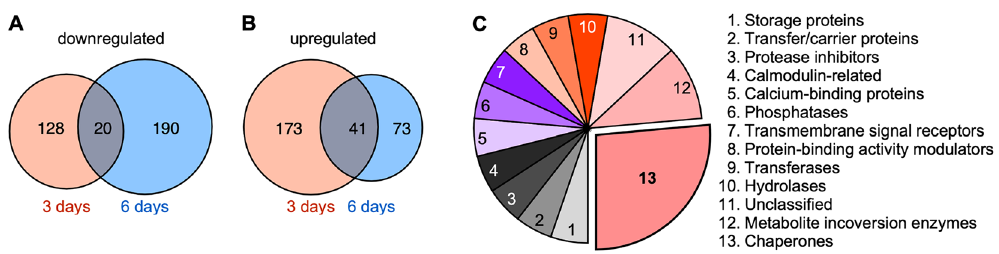
Figure 3. Comparison of the DAPs after a 3-d and 6-d drought. ( A ) Venn diagram illustrating the overlap between the downregulated proteins in the plants subjected to 3-d and 6-d drought treatments. ( B ) Venn diagram illustrating the overlap between the upregulated proteins in the plants subjected to 3-d and 6-d drought treatments. ( C ) Categorization of the 41 proteins up-regulated in both the 3-d and 6-d drought